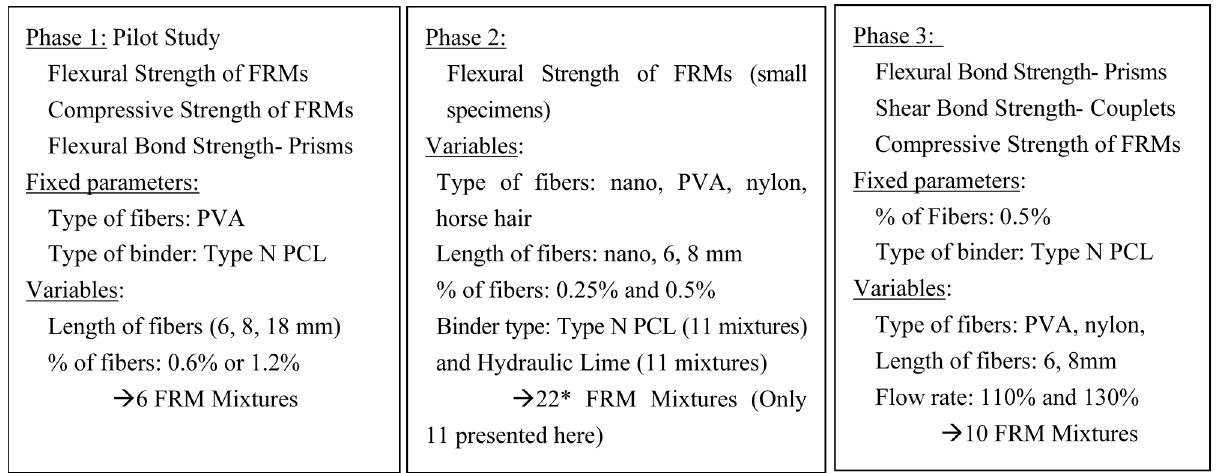
Figure 1. Summary of FRM